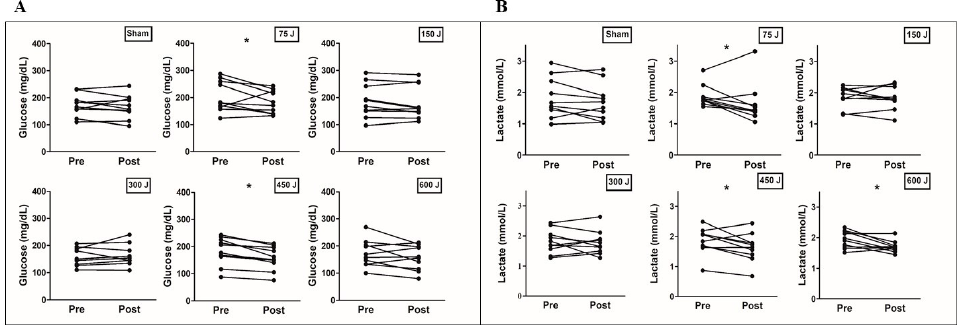
when compared with the baseline.